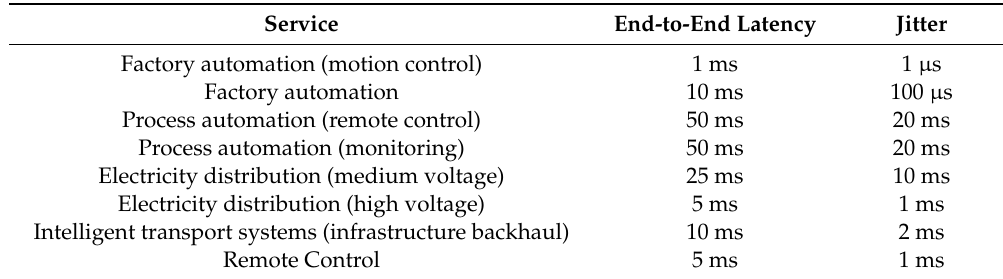
Table 4. End-to-end latency constraints